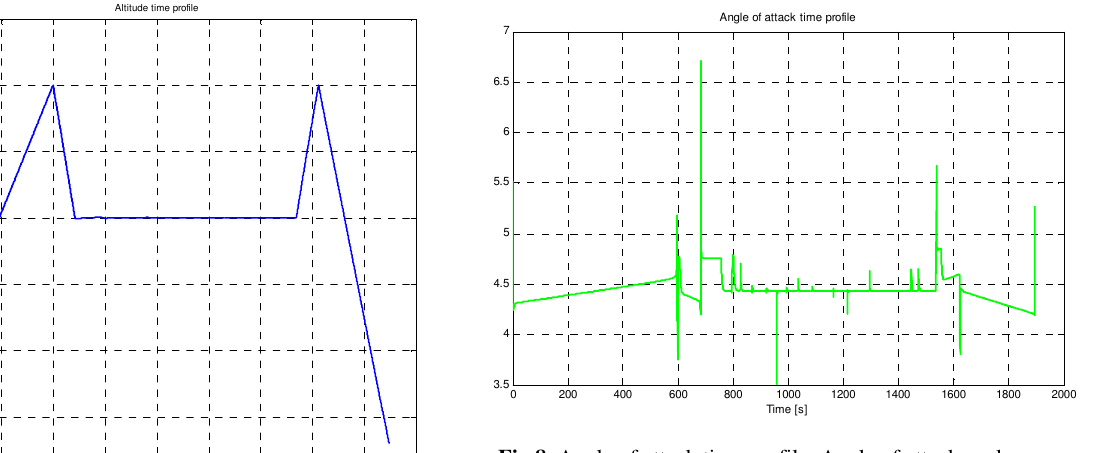
Fig 8. Angle of attack time profile. Angle of attack peaks are used to compensate for lift losses during banks